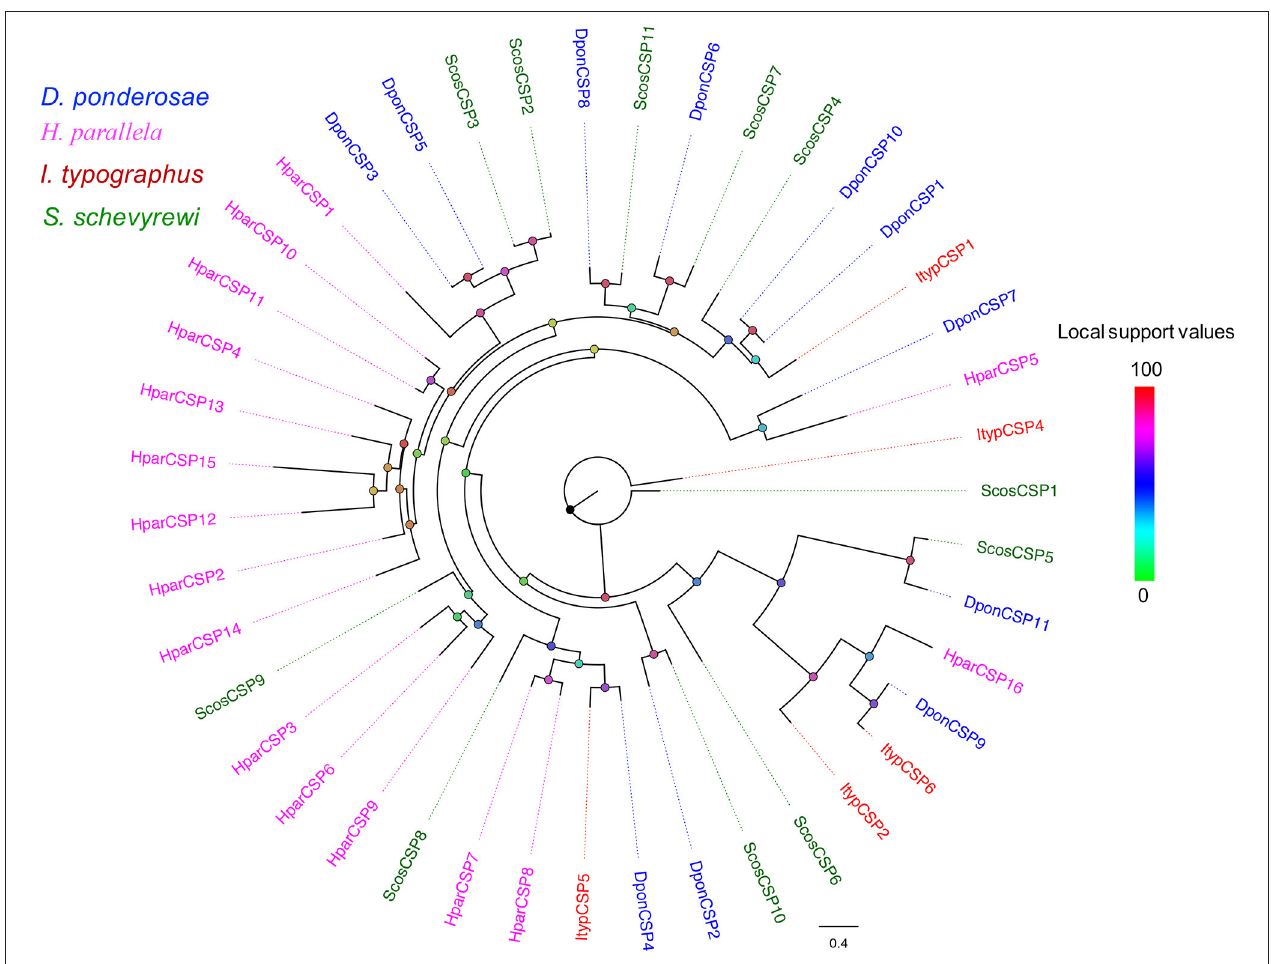
FIGURE 5 | Phylogenetic tree of candidate ScosCSPs with known Coleoptera chemosensory proteins sequences. Tcas, T. castaneum ; Dpon, D. ponderosae ; Hpar, H. parallela ; Ityp, I. typographus ; Scos, S. schevyrewi .